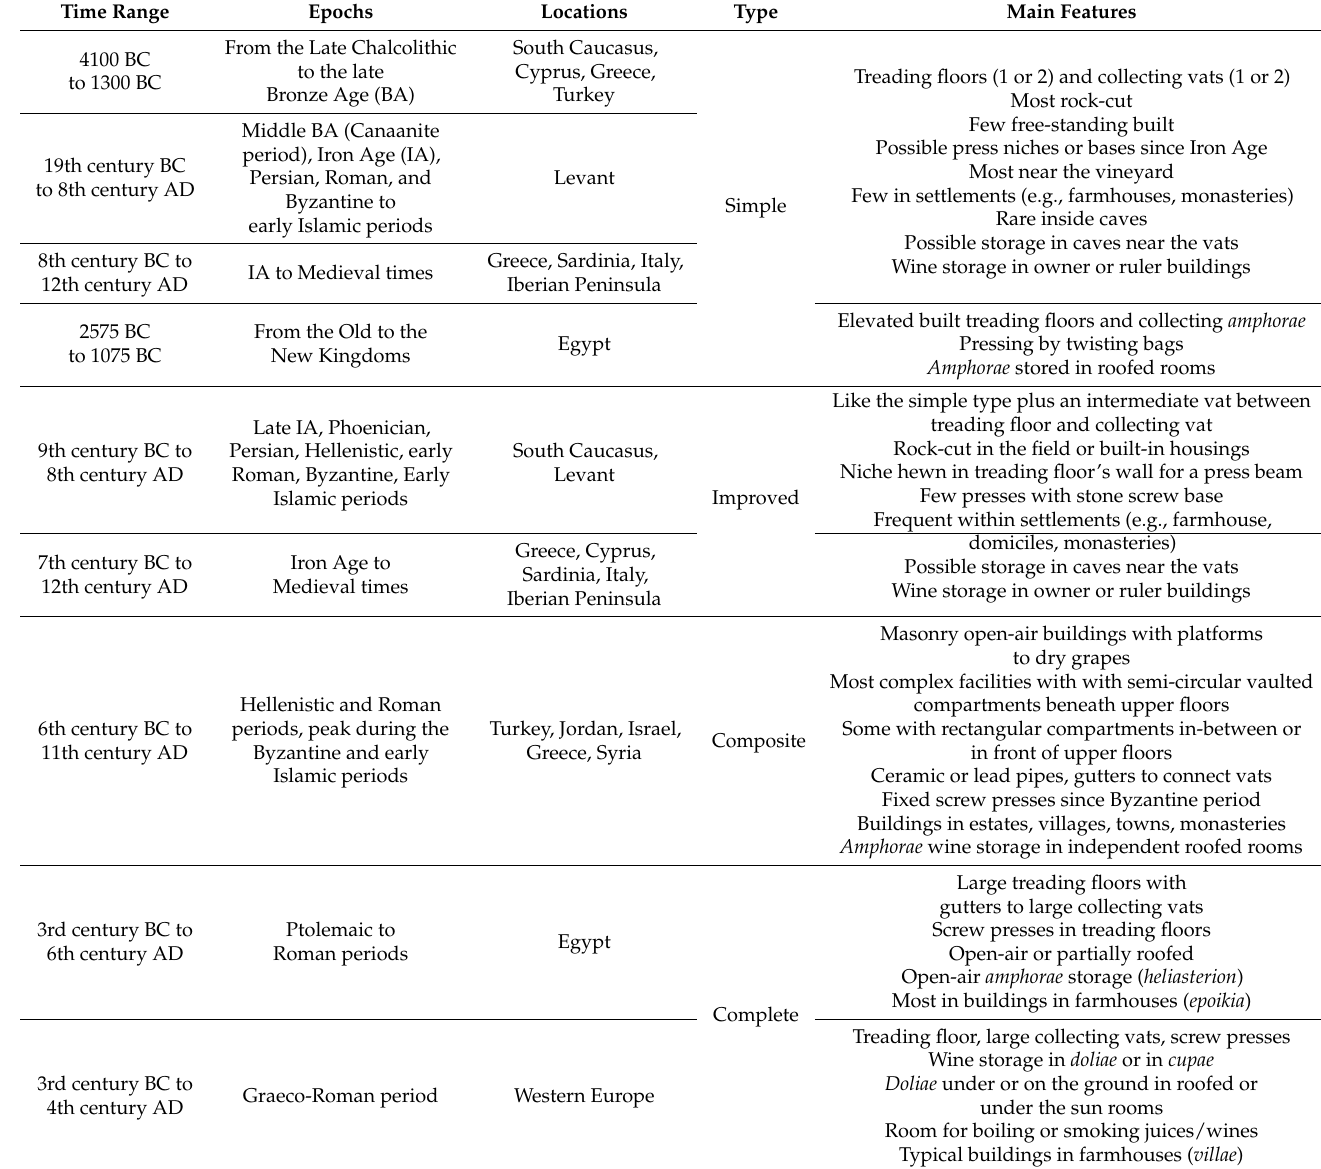
Table 1. Timeline and localization of ancient winery typologies (adapted from the categorization proposed by Avrutis [19] for Levant